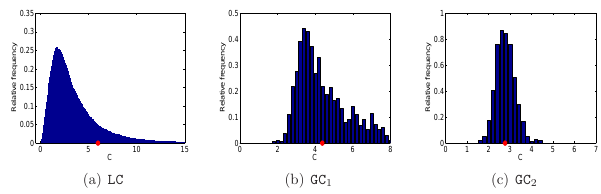
Figure 3: Normalized histograms of estimated C for (a) the LC method, (b) the GC 1 Fig. 3. Normalized histograms of estimated C for (a) the LC method, and (c) the GC 2 method are shown. The results are based on simulated method, (b) the GC 1 method, and (c) the GC 2 method are shown. mBm signals from the U-shape H ( t ) and true C = 3. The red dot represents its The results are based on simulated mBm signals from the U-shape average of estimated C . H(t) and true C = 3. The red dot represents its average of estimated C